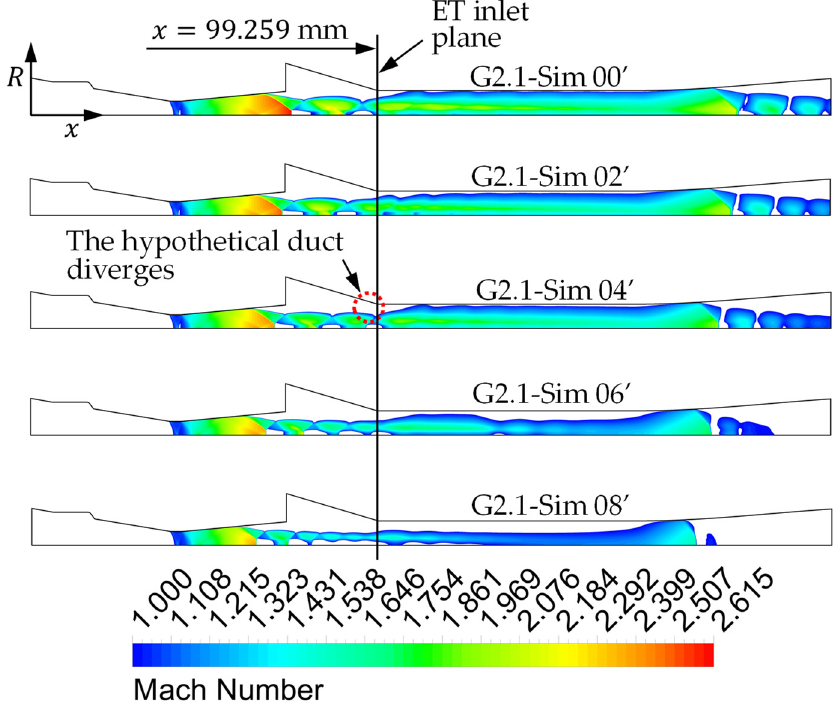
Figure 24. Mach number contour plot (M ≥ 1) of CFD results of ejector G2.1. The operating conditions of sim 00’ to 09’ can be seen in Table 5 (correspond to sim no. 0’ to 9’).